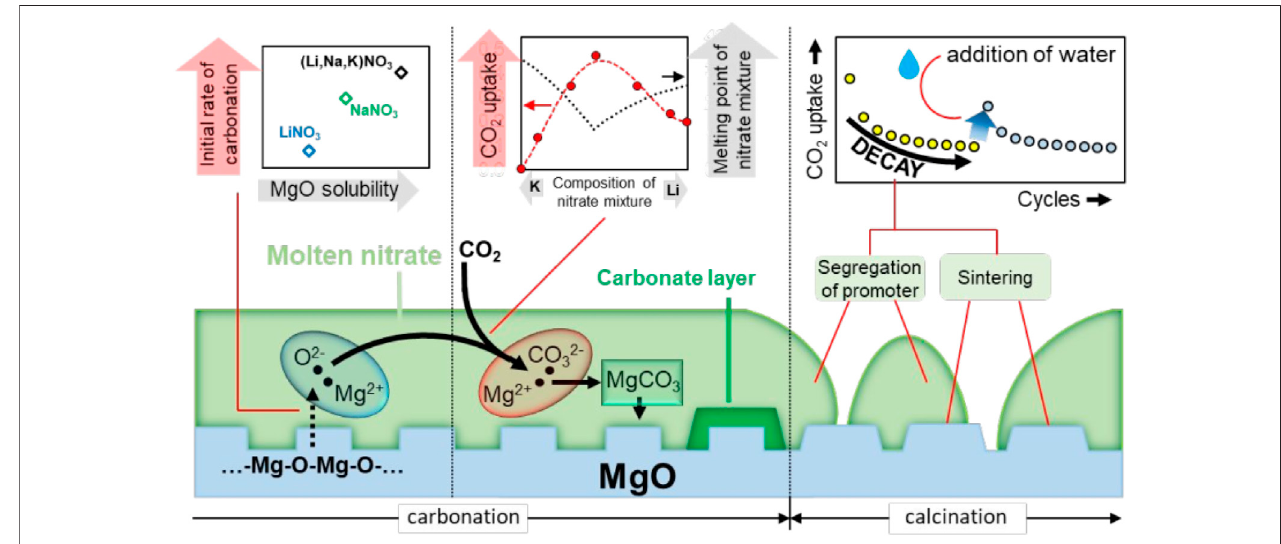
FIGURE 9 | Molten alkali metal nitrate promotes CO 2 adsorption by MgO-based adsorbents (Dal Pozzo et al., 2019).